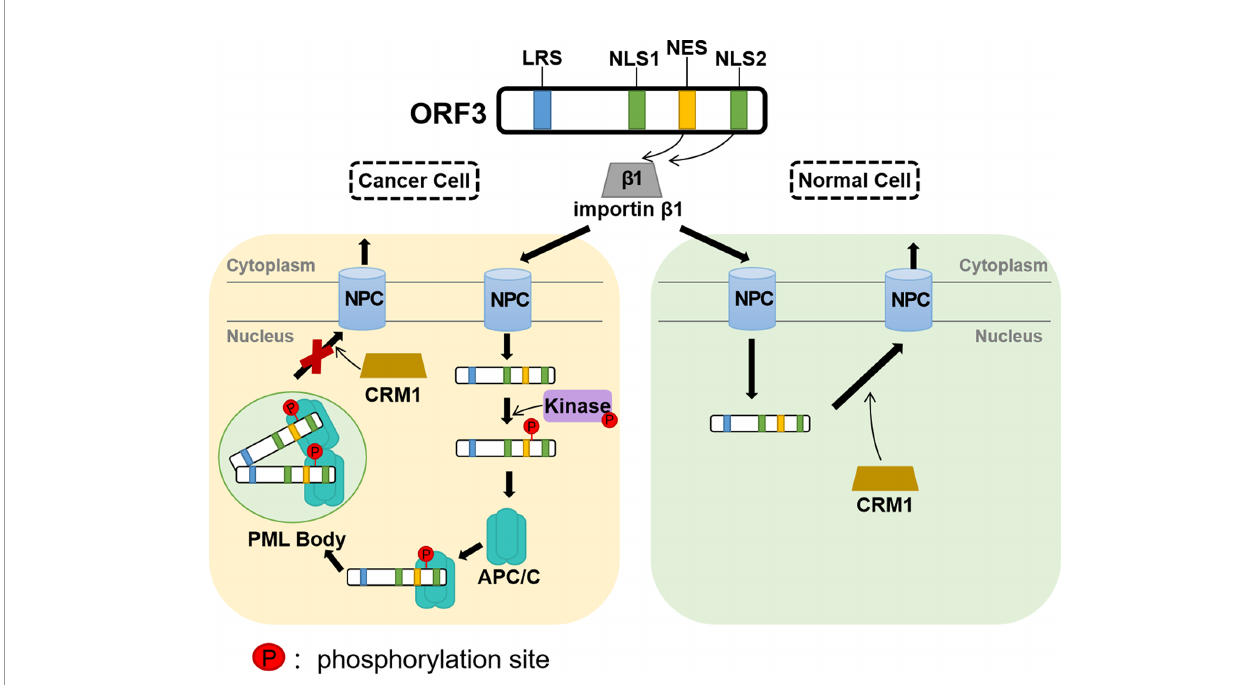
FIGURE 2 | A simulation model of the CAV ORF3 protein associated with various binding partners and its different effects on signal transduction pathways. The ORF3 protein can associate with importin b 1, which facilitates its translocation from the cytoplasm to the nucleus. In tumor cells, the ORF3 protein phosphorylated by Kinase, interacts with a subunit of APC/C called APC1 and directly interacts with PML to induce the formation of PML nuclear bodies. The NES of the ORF3 protein is functional in a CRM1-dependent fashion in normal but not in tumor cells, which indicates that in tumor cells, the ORF3 protein is unable to be driven out of the nucleus with the NES out of function when CRM1 inhibited. This hypothetical model may not apply to non-tumor cells in 1BR3 normal human diploid fi broblasts and the early passage secondary culture of normal human embryonal lung fi broblasts 6689 (Guelen et al.,